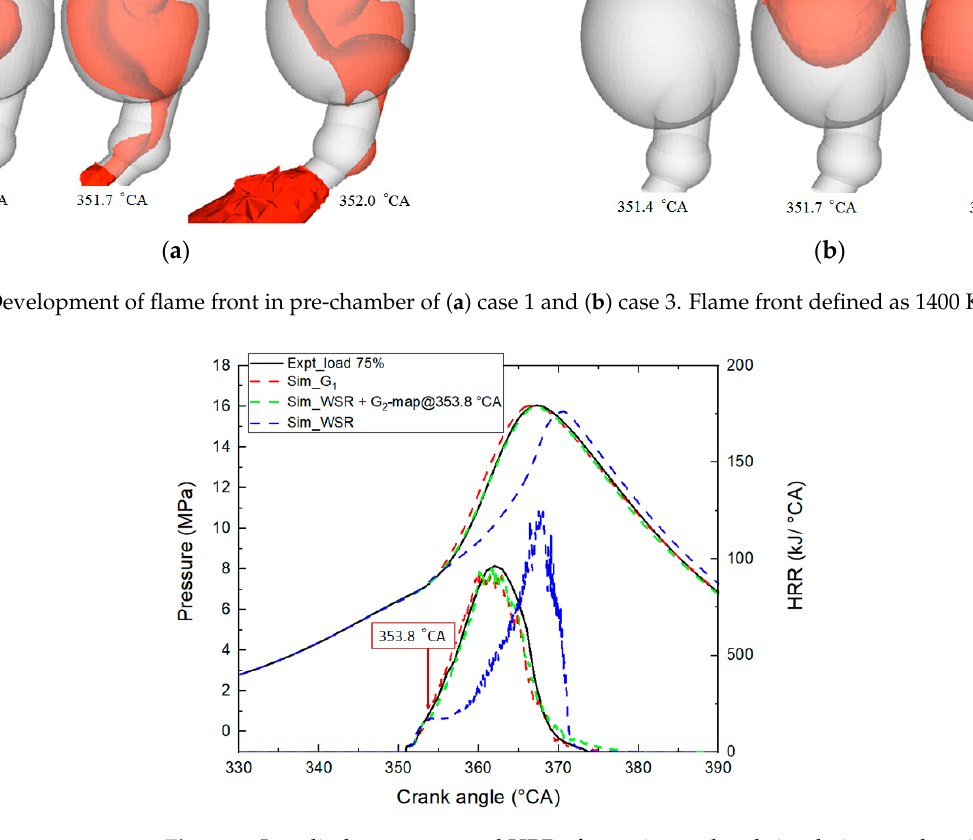
Figure 7. S t at flame tip of the cases with different models. 4.2. Flame Structure Analysis and Choice of T m The mapping timing T m is determined as 353.8 °CA for this studied condition mainly based on calibration rather than in a predictive manner, and it is necessary to further discuss the choice of T m to improve the predictivity of this approach. In this section, the flame structure evolution based on parameters of 𝑢 (cid:4593) , Da and the Borghi–Peters diagram is analyzed in detail. Local temperature, 𝑢 (cid:4593) and Da in each simulation cell along the orifice centerline (seen in Figure 3) using WSR alone or the G-equation model (G 1 ) alone are provided in Figures 8–10, respectively. The temperature profiles show that flame development speeds predicted by the two models are remarkably different. Specifically, at 352 °CA, jet flame length is a bit longer using the WSR model than using G-equation; however, flame length shows the opposite result after 353 °CA, which indicates that the simulated flame develops faster with the WSR model at the early stage of the jet flame development pro- cess, while later on, the simulated flame develops more slowly using WSR model. Figure 9 shows local 𝑢 (cid:4593) results at different times using the two models. It is obvious that the 𝑢 (cid:4593) of the flame is profoundly larger at 352 °CA than later on. Results using two models show very similar trends, while only the flame lengths are different, as earlier mentioned. The